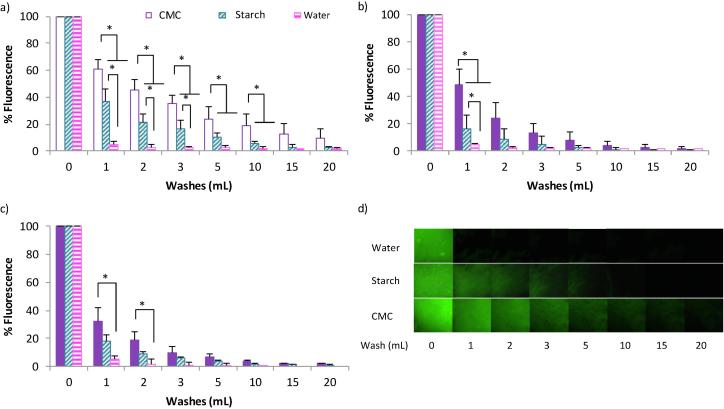
In vitro retention profiles of samples on the front (a), rear (b) and side (c) of ex vivo pig tongue and example fluorescent images (d). Significance value of p < 0.05 is represented by * between respective groupings (n = 3). Error bars are ±standard deviation. Fluorescence intensity of the retained polysaccharide was quantified by ImageJ software after being washed with artificial saliva up to 20 mL.